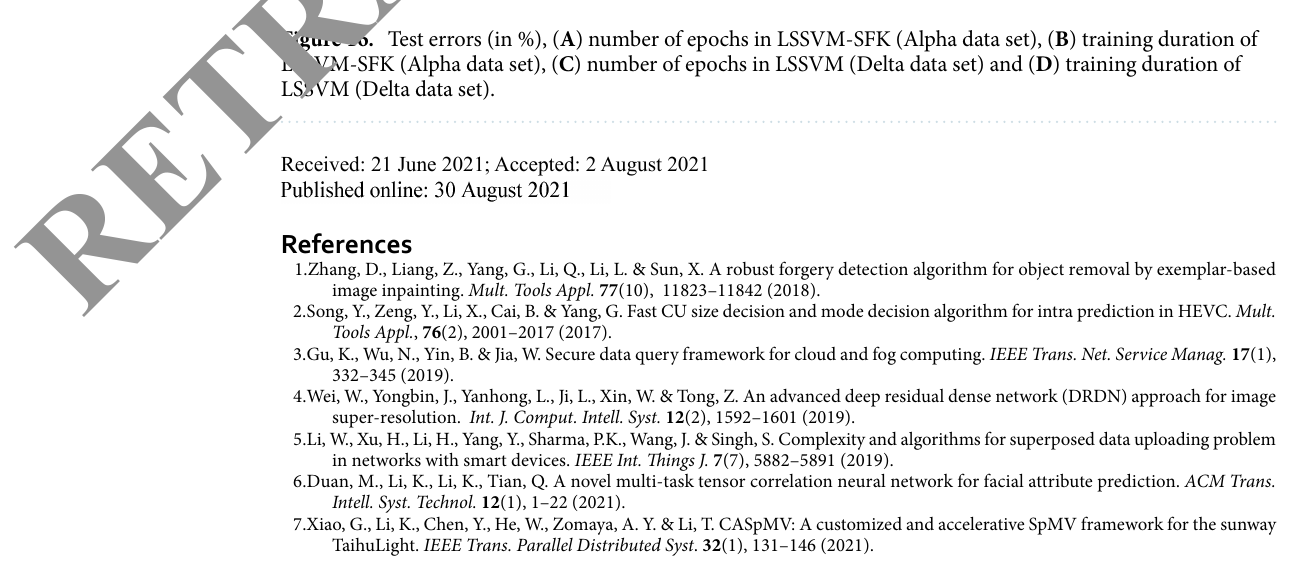
Figure 16. Test errors (in %), ( A ) number of epochs in LSSVM-SFK (Alpha data set), ( B ) training duration of LSSVM-SFK (Alpha data set), ( C ) number of epochs in LSSVM (Delta data set) and ( D ) training duration of LSSVM (Delta data